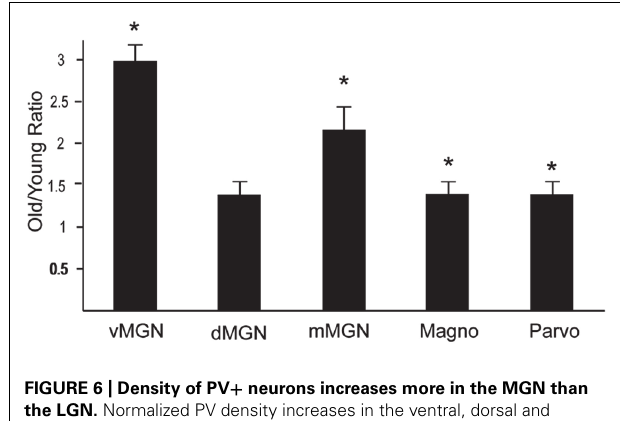
FIGURE 6 | Density of PV + neurons increases more in the MGN than the LGN. Normalized PV density increases in the ventral, dorsal and magnocellular MGN (vMGN, dMGN, and mMGN; respectively), and from the magnocellular and parvocellular layers of the LGN.Values were found by taking the ratio of the old to young PV densities in each subdivision. Asterisks mark the regions that showed statistically significant age-related increases in the density of PV + neurons. Asterisks indicate significance by an unpaired t -test at an alpha level of